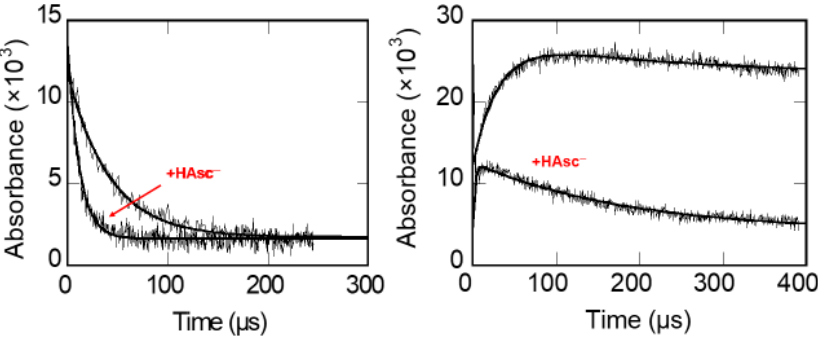
Figure 1. Left : acceleration of the decay of Pepsin-Trp • by ascorbate. Right : formation of Pepsin- TyrO • by LRET and the accelerating effect of ascorbate on its decay [63].